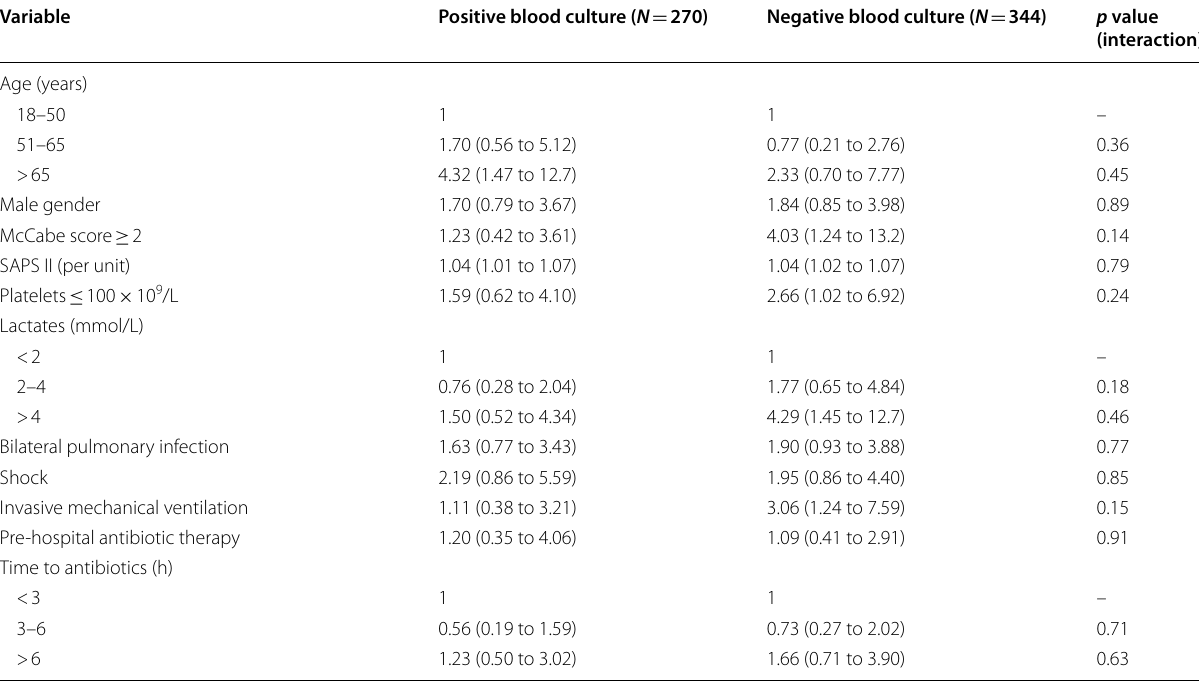
SAPS II Simplified Acute Physiology Score